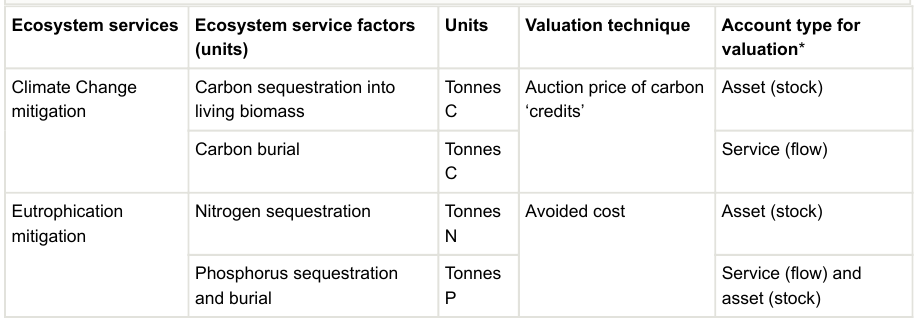
The measurement and valuation of ecosystem services related to mangrove, tidal marsh and seagrass, assessed in this study. C = carbon, N = nitrogen, P =